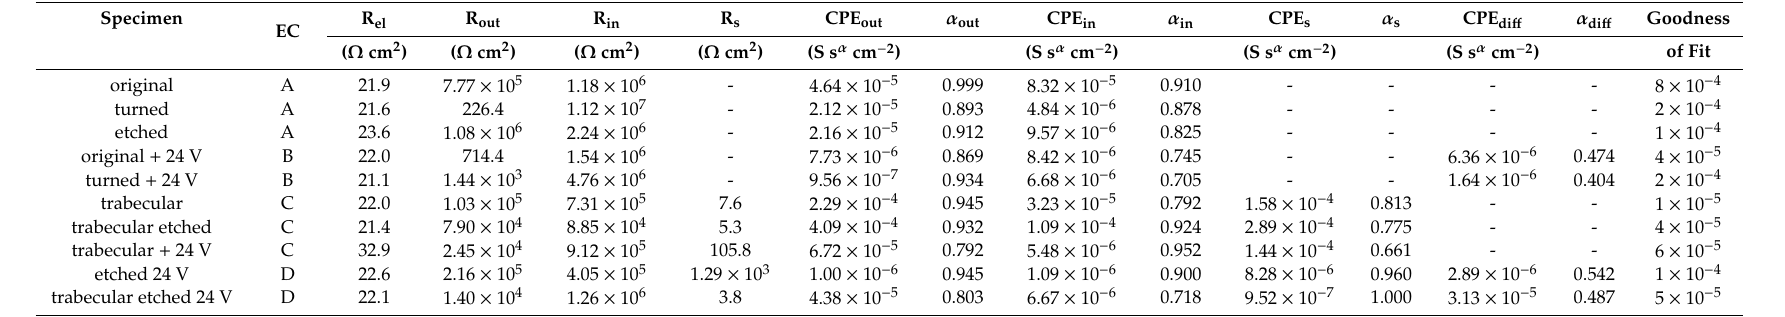
Table 1. Impedance spectra evaluation according to the used equivalent circuit